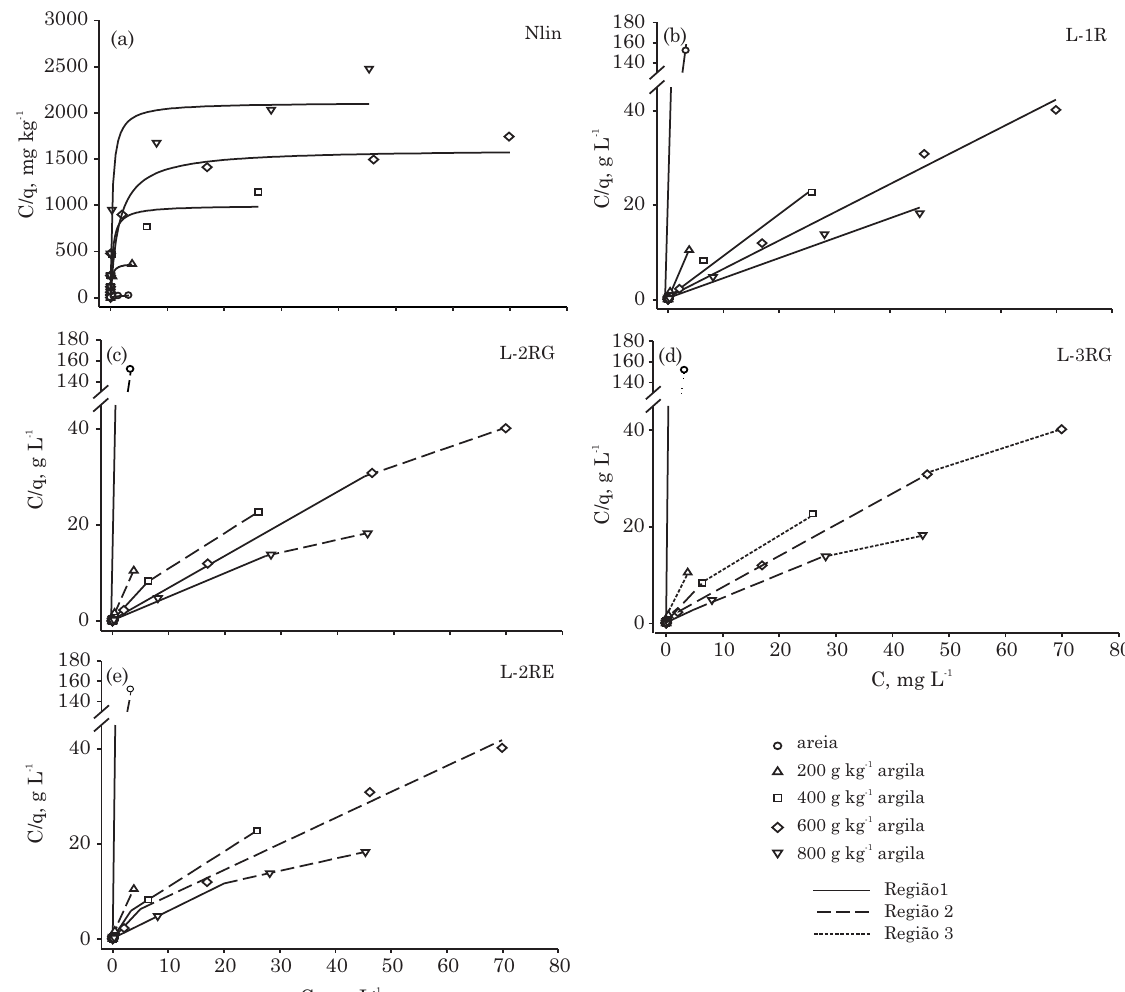
Figura 1. Isotermas de adsorção de fósforo em um solo misturado com areia em diferentes proporções para formar texturas de 0 a 800 g kg -1 de argila. Modos de ajuste do modelo: NLin = não linear com região única (a); L-1R = linearização com região única (b); L-2RG = linearização com duas regiões, ajuste gráfico (c); L-3RG = linearização com três regiões, ajuste gráfico (d); e L-2RE = linerização com duas regiões, ajuste estatístico